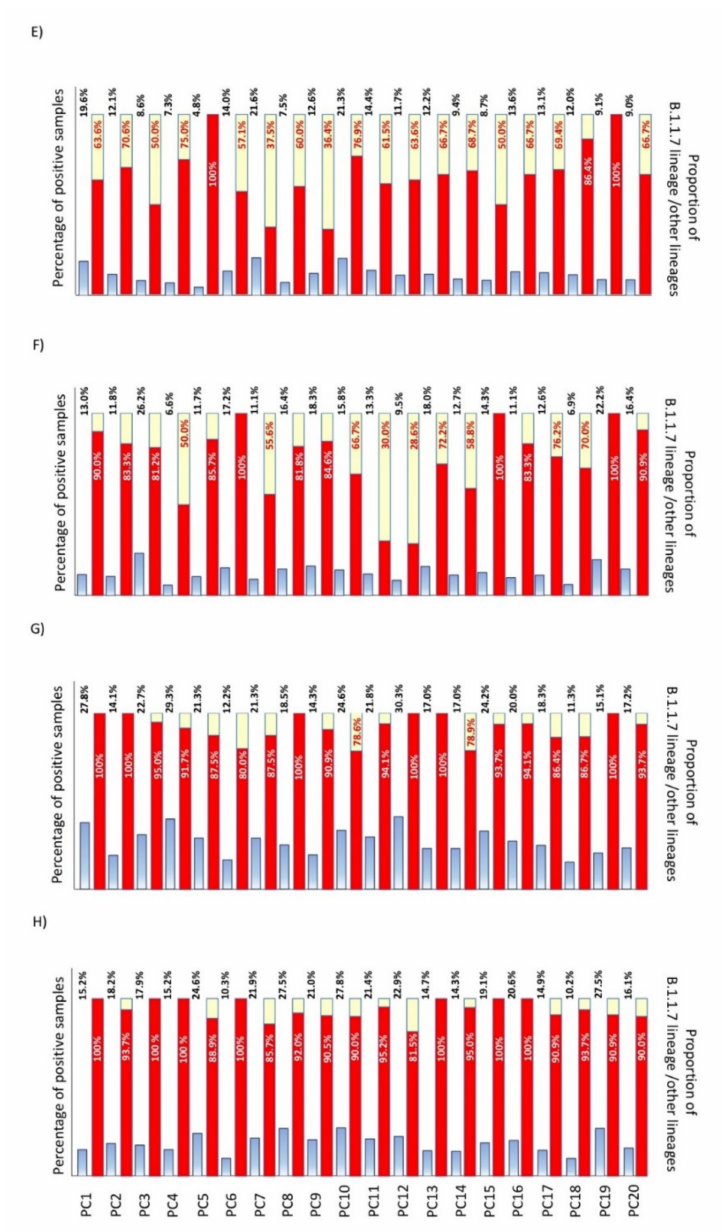
Figure 1. Temporal evolution in the incidence of B.1.1.7 (Alpha variant) in our health area: ( A ) first biweekly period (2–17 January); ( B ) second biweekly period (18–31 January); ( C ) third biweekly period (1–14 February); ( D ) fourth biweekly period (15–28 February); ( E ) fifth biweekly period (1–14 March); ( F ) sixth biweekly period (15–28 March); ( G ) seventh biweekly period (29 March–11 April); ( H ) eighth biweekly period (12–22 April). All dates correspond to 2021. PC: primary